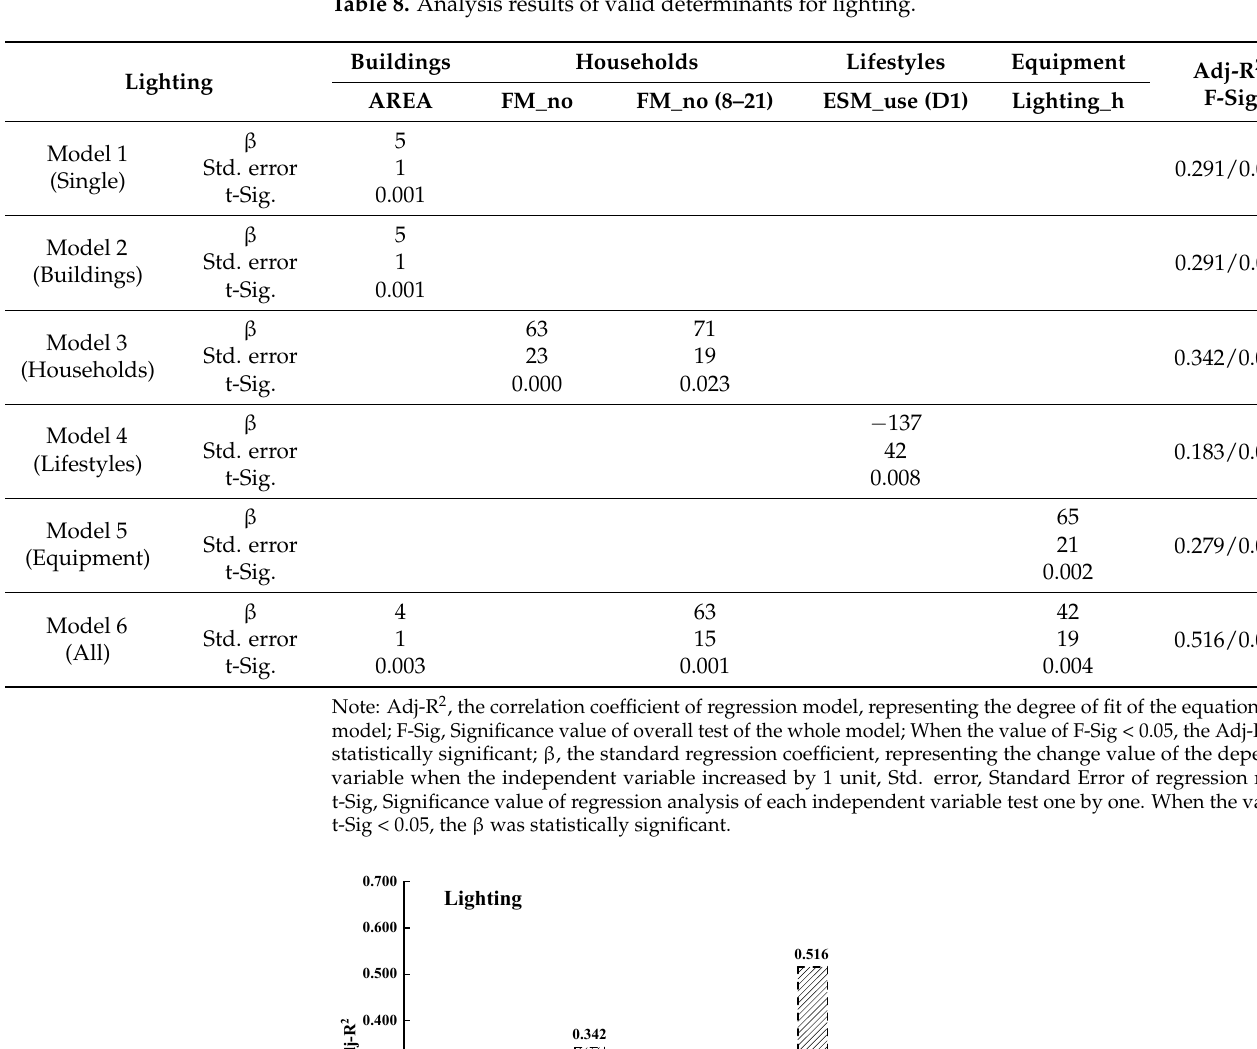
Table 8. Analysis results of valid determinants for lighting.